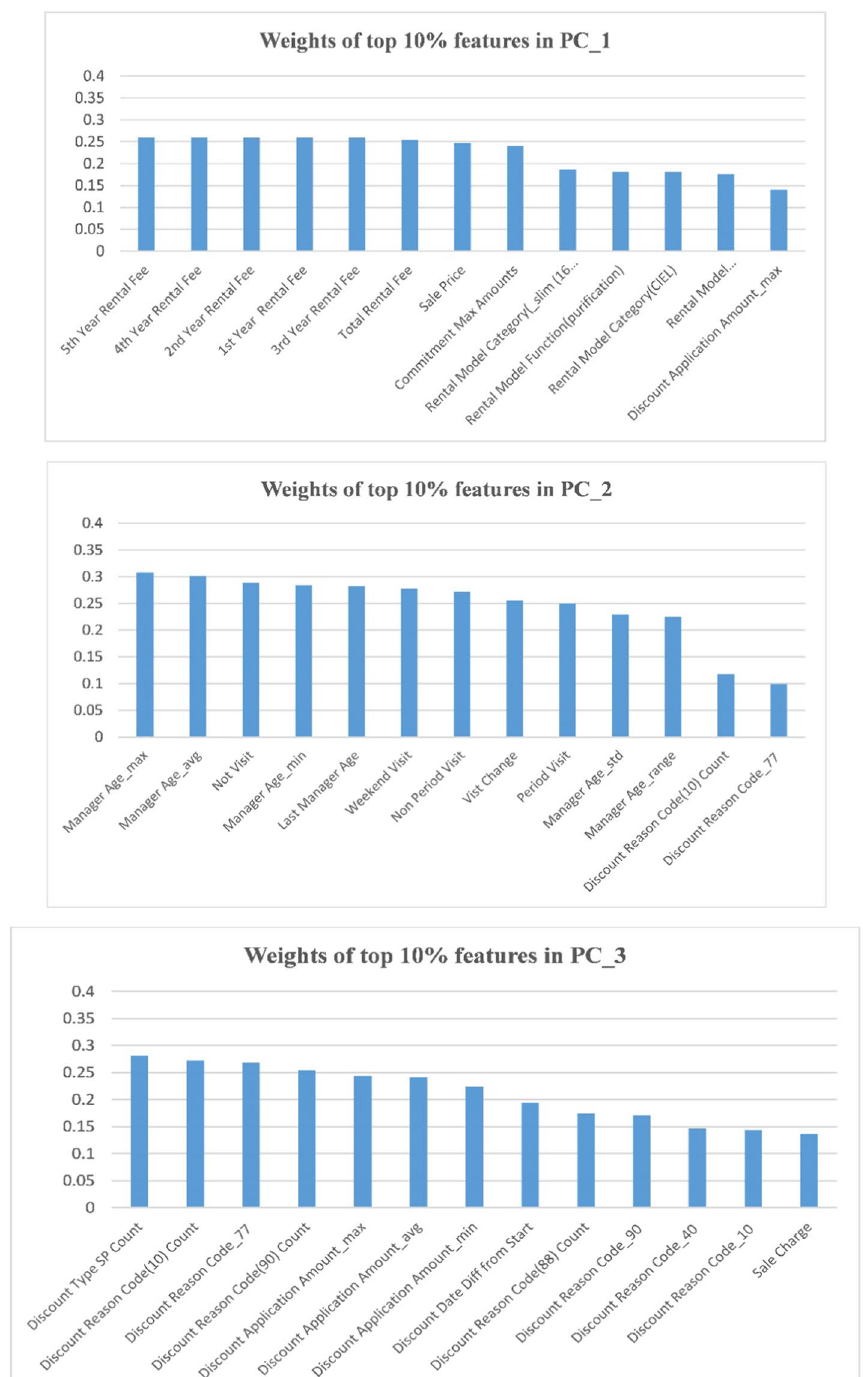
Fig. 5 Weights of the top 10% of features in the top four principal components ( a ) weights of PC_1 ( b ) weights of PC_2 ( c ) weights of PC_3 ( d ) weights of